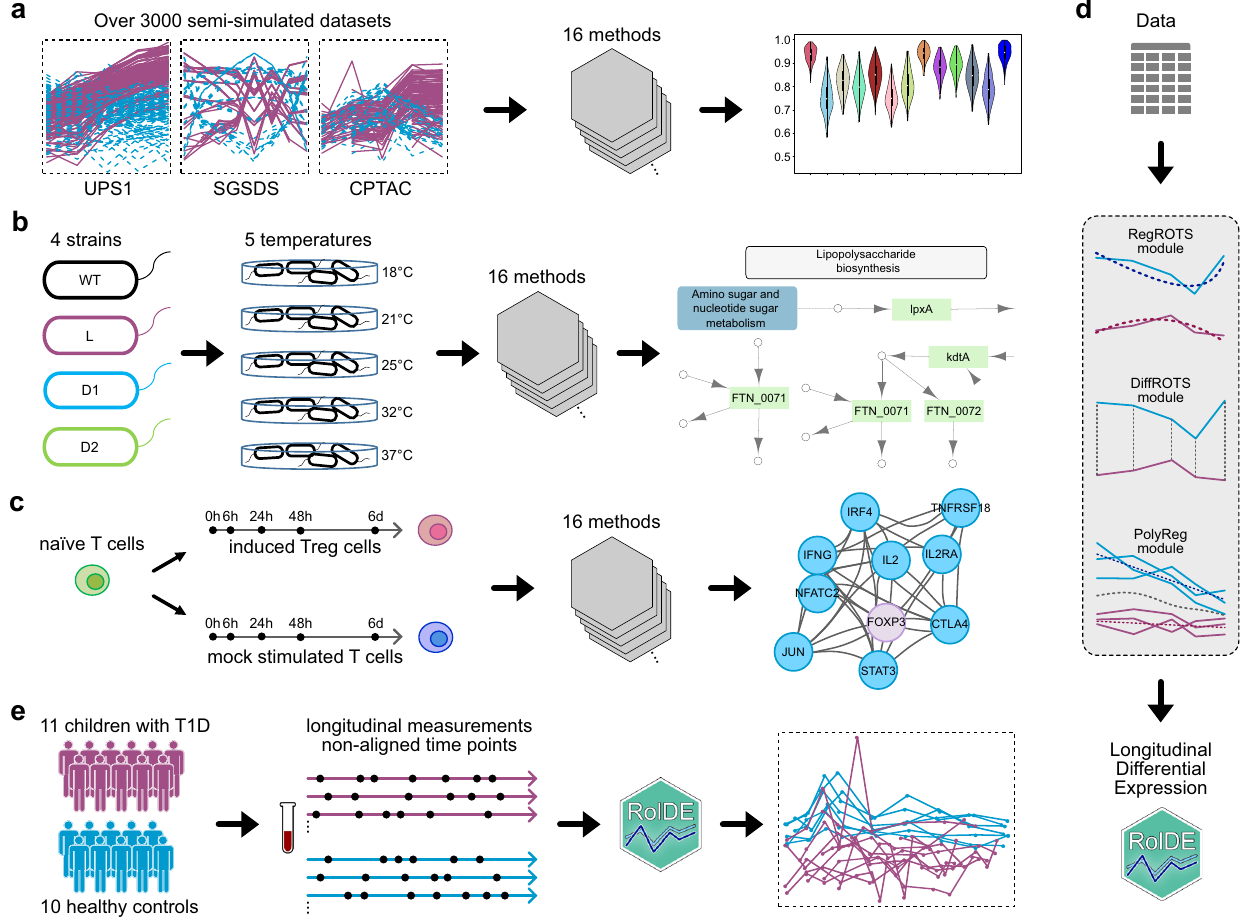
Fig. 1 | Illustration of the benchmark design and the new RolDE method. a In total over 3000 semi-simulated spike-in proteomics datasets with two conditions, fi ve (UPS1and CPTAC) or eight (SGSDS)timepoints, and varying trend differences between the conditions were generated for an extensive evaluation of the perfor- manceofthemethods. b Reproducibilityofthemethodsacrosstechnicalreplicates and their ability to provide biologically relevant fi ndings in terms of known asso- ciated KEGG pathway was evaluated in an experimental Francisella tularensis sub- species novicida (Fn) dataset. c Biological relevance of the fi ndings of the methods was further assessed in a publicly available proteomics data of human induced T regulatory cell (iTreg) differentiation using known Treg-related gene sets from multiple sources. d Schematic illustration of the Robust longitudinal Differential Expression (RolDE) method, which is a composite method, consisting of three